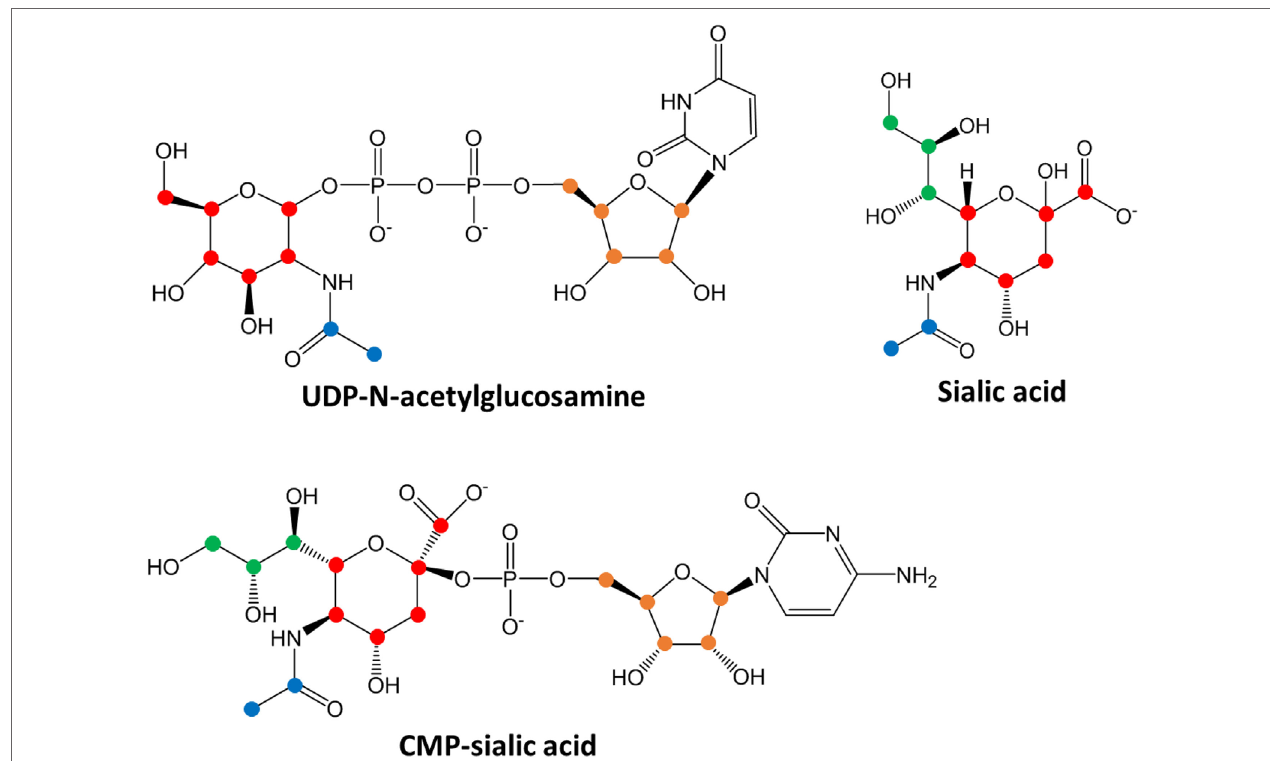
FigUre 4 | Chemical structures of sialic acid pathway intermediates. Carbon atoms derived from each biosynthetic component are denoted by different colors: red, glucose-derived hexose ring; green, PEP-derived moiety; blue, acetyl-CoA-derived moiety and orange, PRPP-derived ribose ring in the uridine monophosphate or cytosine monophosphate group. Biosynthesis of uridine diphosphate (UDP)-N-acetylglucosamine, sialic acid or cytidine monophosphate (CMP)-sialic acid from 13 C-glucose would result in hexose ring carbons (red) becoming 13 C-labeled, with additional labeling on the other colored carbons depending on extent of 13 C-glucose incorporation into other metabolic pathways. By measuring the abundances of all isotopic species showing hexose ring (red) 13 C-labeling, the amount of CMP-sialic acid production through the hexosamine-sialic acid pathway can be determined, and the rate of increase of this abundance reflects activity through the hexosamine-sialic acid pathway.